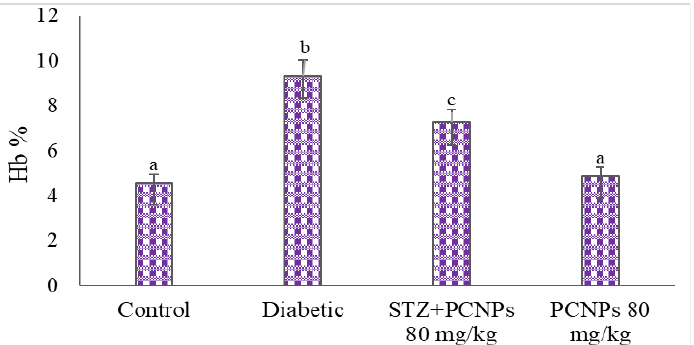
Figure 4. Activities of PCNPs on HbA1c of experimental and control group. Values are means ± SD for six rats at p < 0.05 (DMRT). a PCNPs alone treated group compared with control group. b Diabetic group compared with control group. c Treatment group compared with diabetic control.